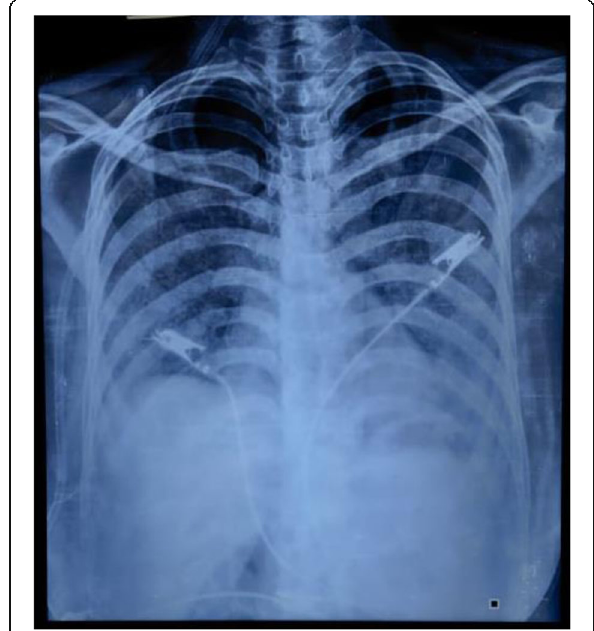
Fig. 1 Chest X-ray AP view, showing diffuse PAP